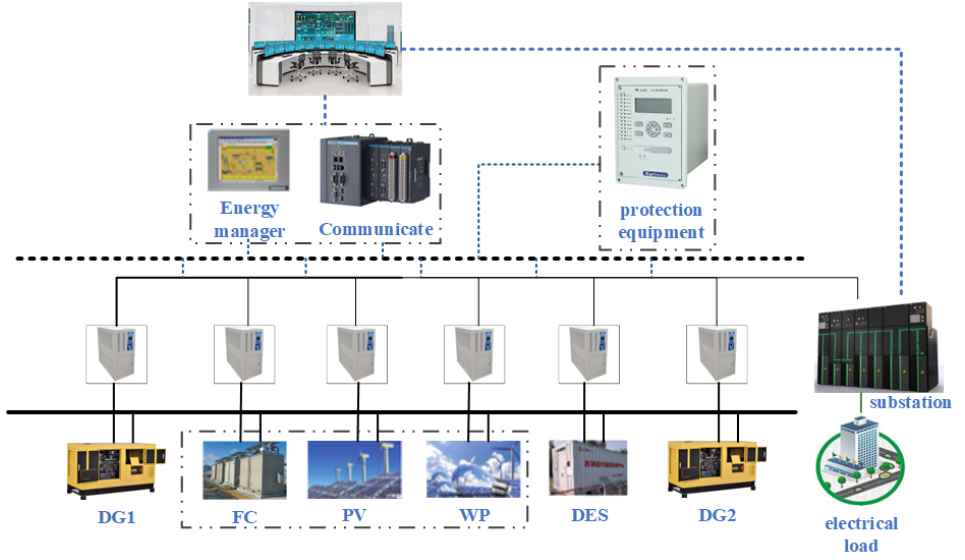
Figure 1. Distributed energy system